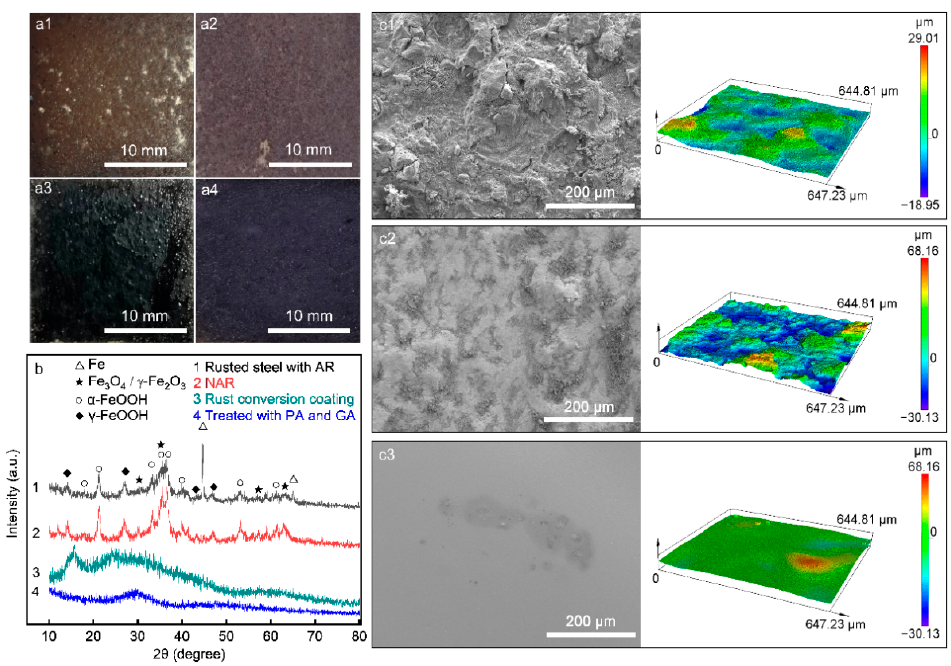
Figure 2. Optical images of ( a1 ) Rusted steel with AR, ( a2 ) NAR, ( a3 ) Rust conversion coating and ( a4 ) Treated with PA and GA. ( b ) XRD patterns of Rusted steel under different treatment states corresponding to ( a1 – a4 ). SEM and LSCM images of ( c1 ) Rusted steel with AR, ( c2 ) NAR and ( c3 ) Rust conversion coating.